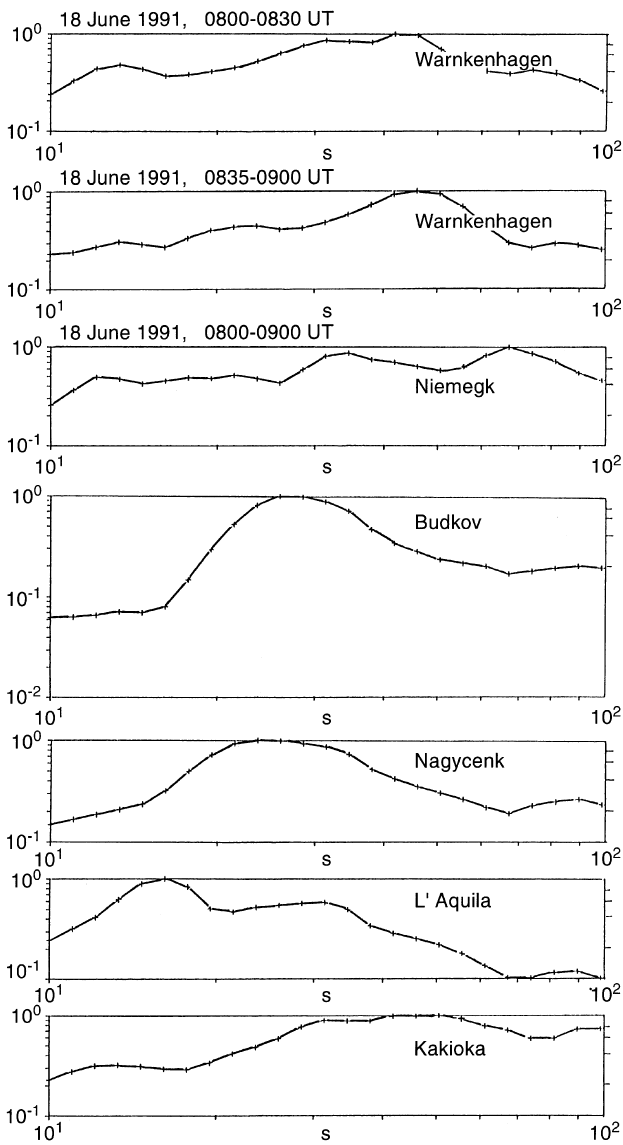
Fig. 1. Amplitude spectra of the 0800–0900 UT, 18 June, 1991, event at di(cid:128)erent stations. On the vertical axis, amplitudes reduced to a maximum amplitude 1 within the plotted range, on the horizontal axis periods